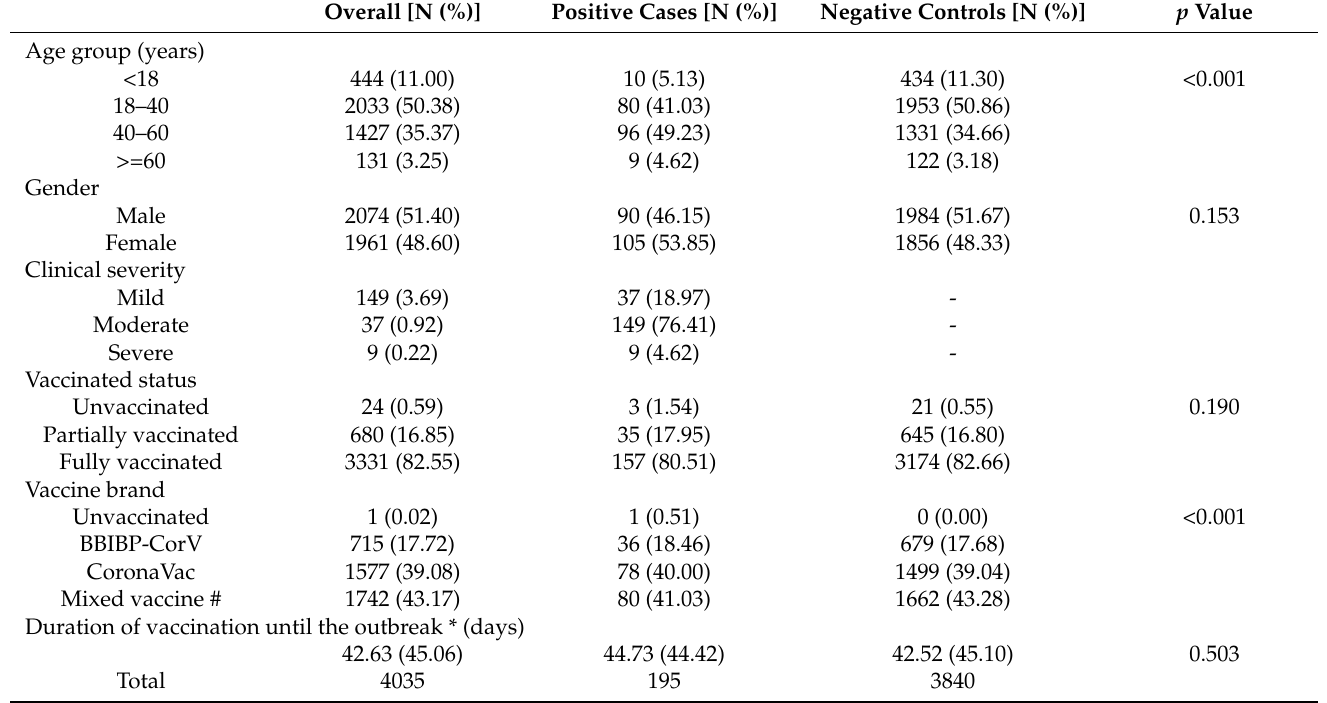
Table 2. Characteristics of SARS-CoV-2 cases and controls for vaccine effectiveness